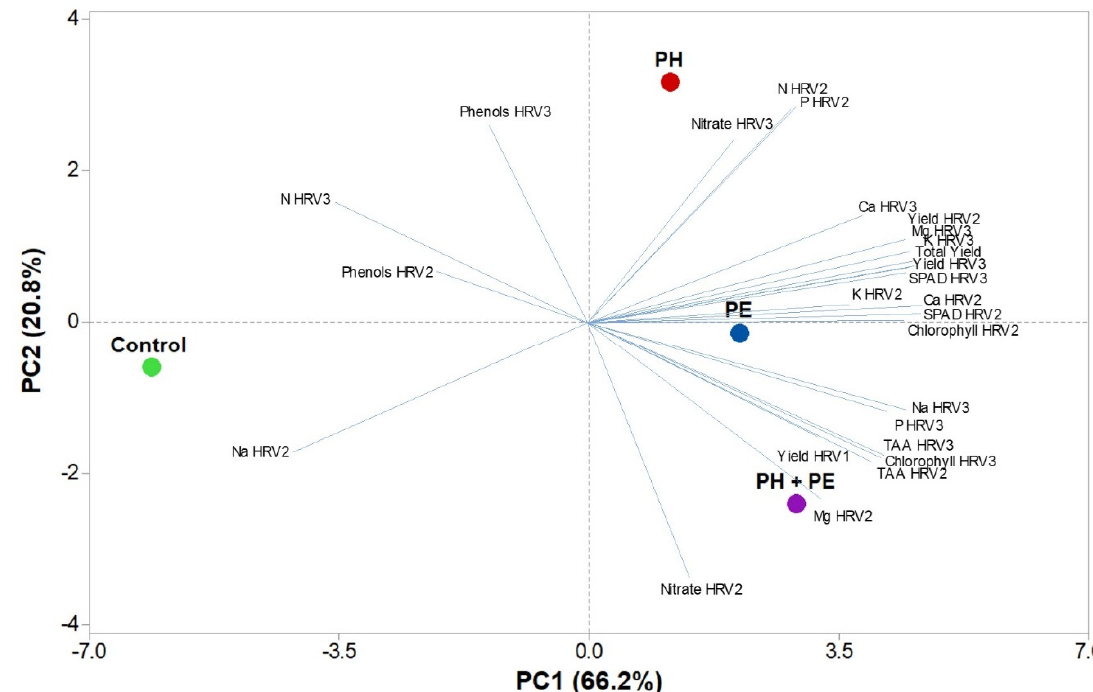
Figure 1. Principal component loading plot and scores of principal component analysis (PCA) of all agronomical and qualitative parameters of perennial wall rocket harvested (HRV) three times during the cultivation cycle, treated with either PE or PH or combined plant-based biostimulants (PH + PE).